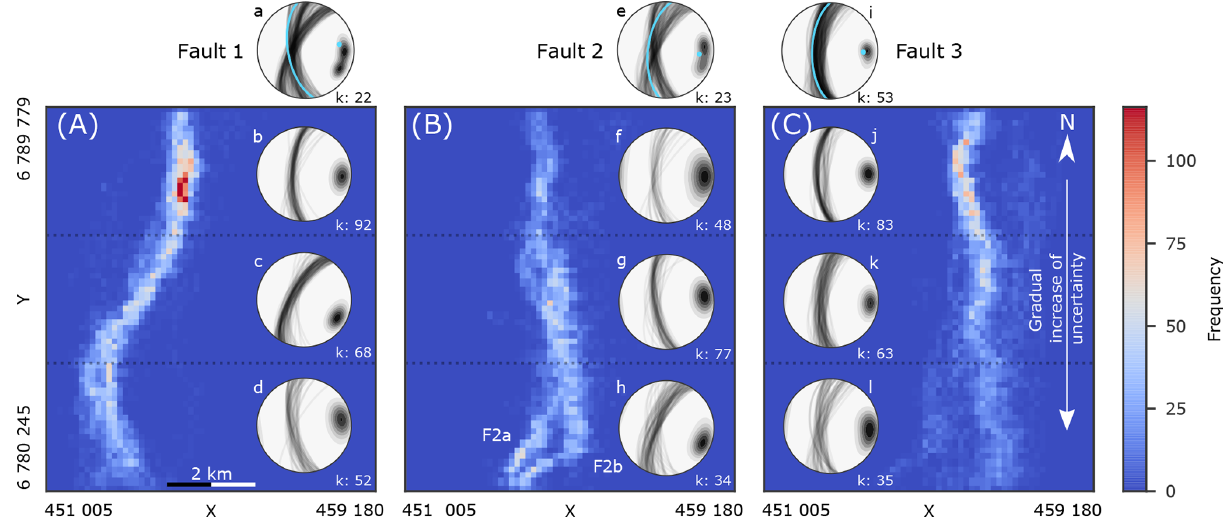
Figure 3. 2-D histograms for Faults 1 (A) , 2 (B) and 3 (C) for the depth slice at 2km ± 0 . 1. Stereonet plots of Faults 1–3 (columns) with all fault strike orientations along the fault length plotted combined in the first row (a, e, i) . To discriminate changing trends in actual fault orientation from interpretation uncertainty, rows two to four plot data from bins separated by dashed blue lines, from the northern (c, g, k) , middle (d, g, l) and southern bins (e, h, m) . Blue planes and poles in the top row (a, e, i) show Bingham analysis mean pole from Fossen and Hesthammer (1998) for reference.